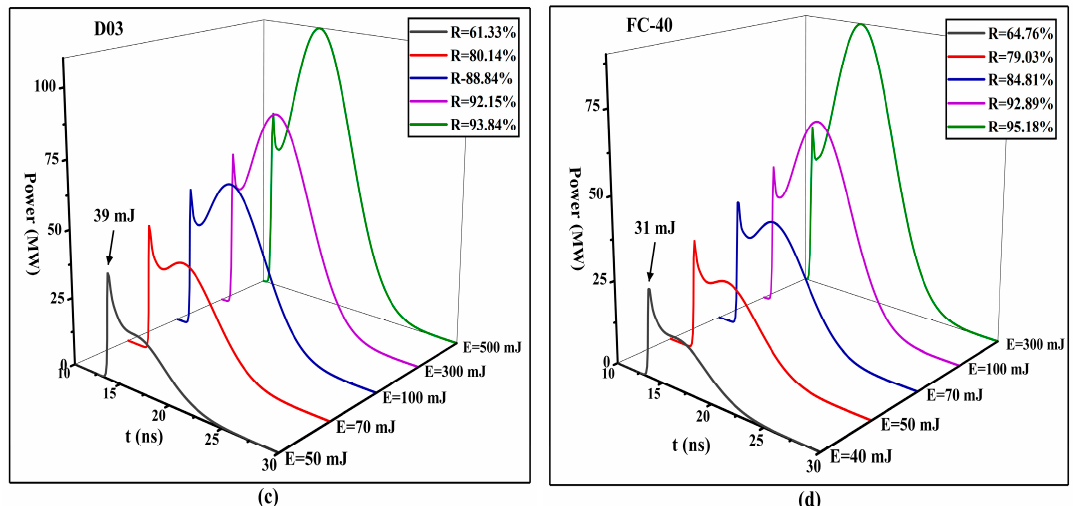
Figure 3. Evolution of Stokes temporal waveform and change in the ratio of trailing-edge energy to the entire waveform energy (R) with different pump energies (E) and an interaction length between Stokes and the pump of 15 cm: ( a ) the SBS medium of FC-70; ( b ) the SBS medium of HS-260; ( c ) the SBS medium of D03; ( d ) the SBS medium of FC-40.